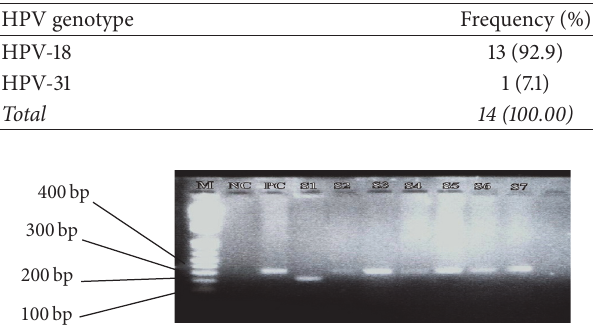
Figure 2: An electropherogram of 2nd nested PCR products of human papillomavirus. The 322 bp and 263 bp fragments corre-